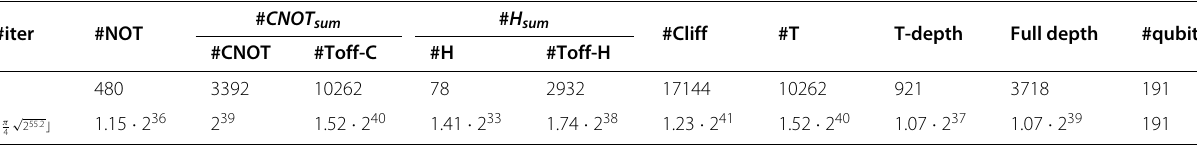
Table 8 The cost of quantum exhaustive search in QRKR